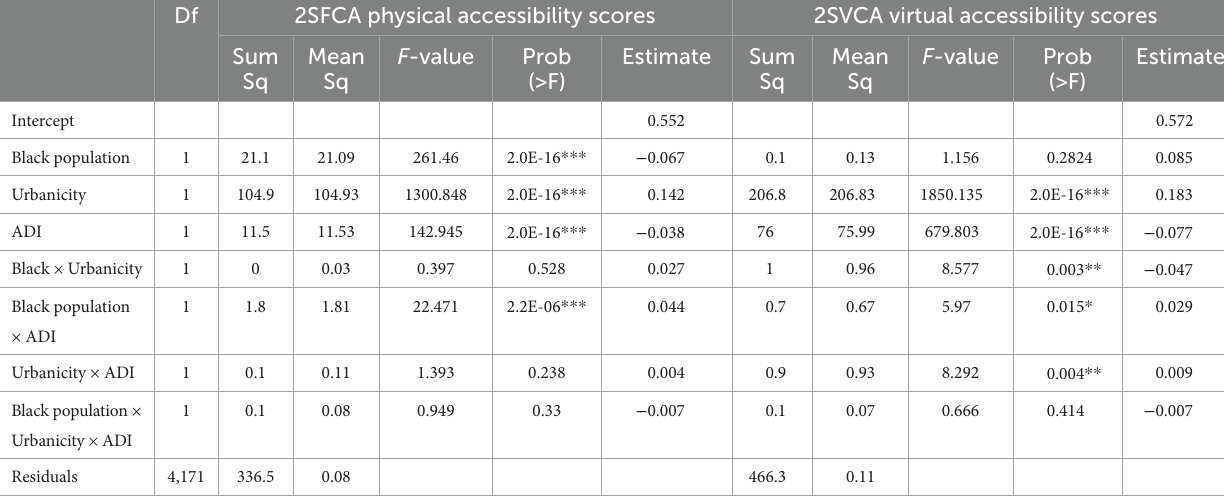
TABLE 3 Three-way ANOVA on 2SFCA and 2SVCA scores. Df